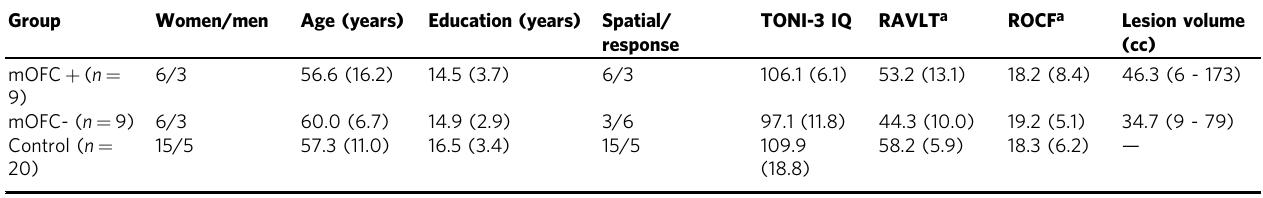
Table 2 Participant demographics, navigation strategies, and performance on neuropsychological tests Group